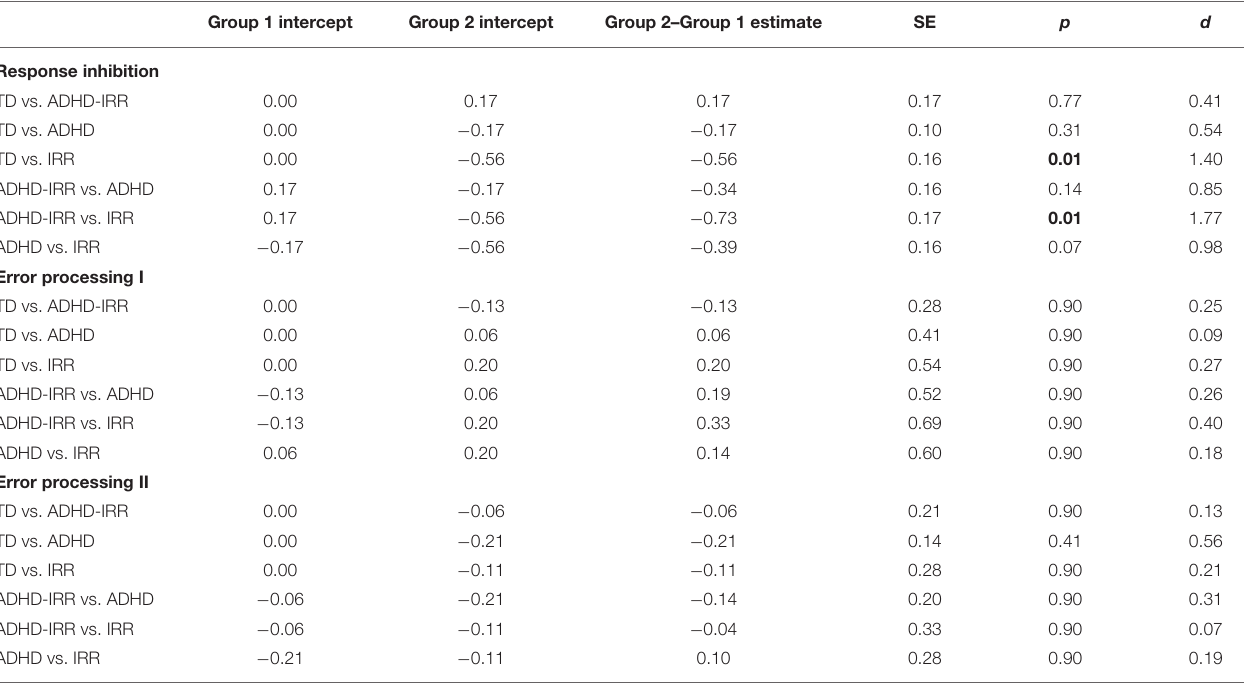
TABLE 2 | Comparison of latent brain activation patterns across